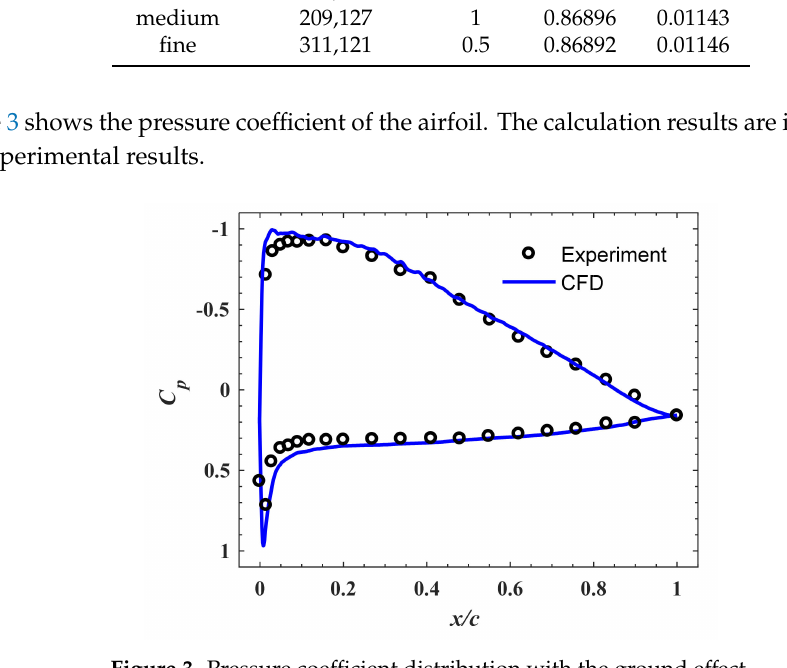
Figure 3. Pressure coe ffi cient distribution with the ground e ff